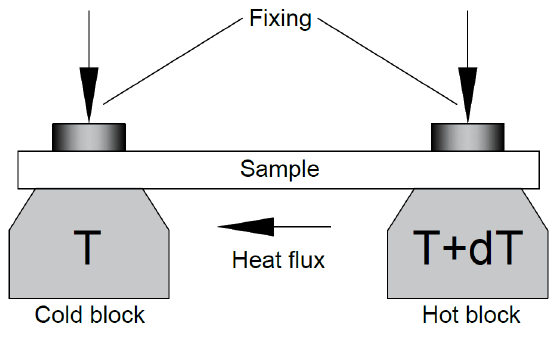
Figure 11. Sematic illustration of the TEP instrument.